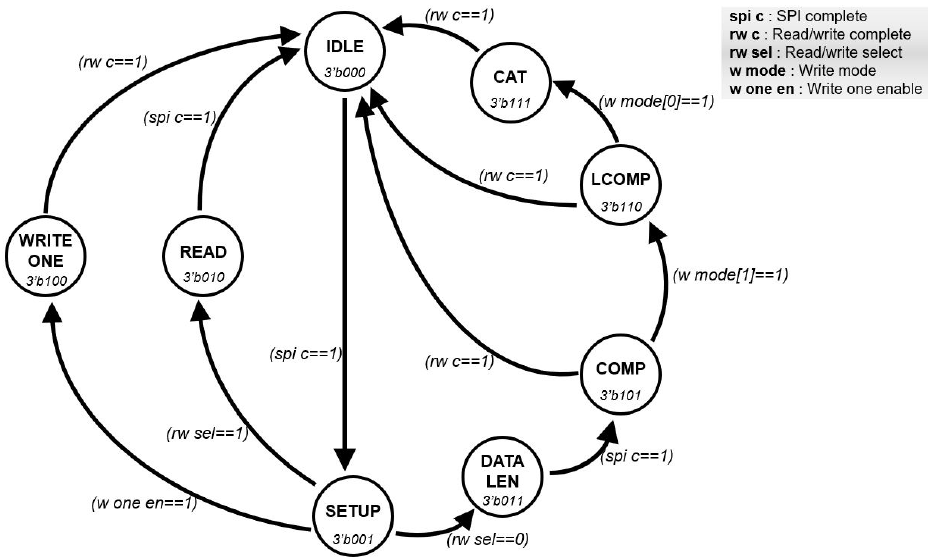
Figure 5. The architecture of the FSM.